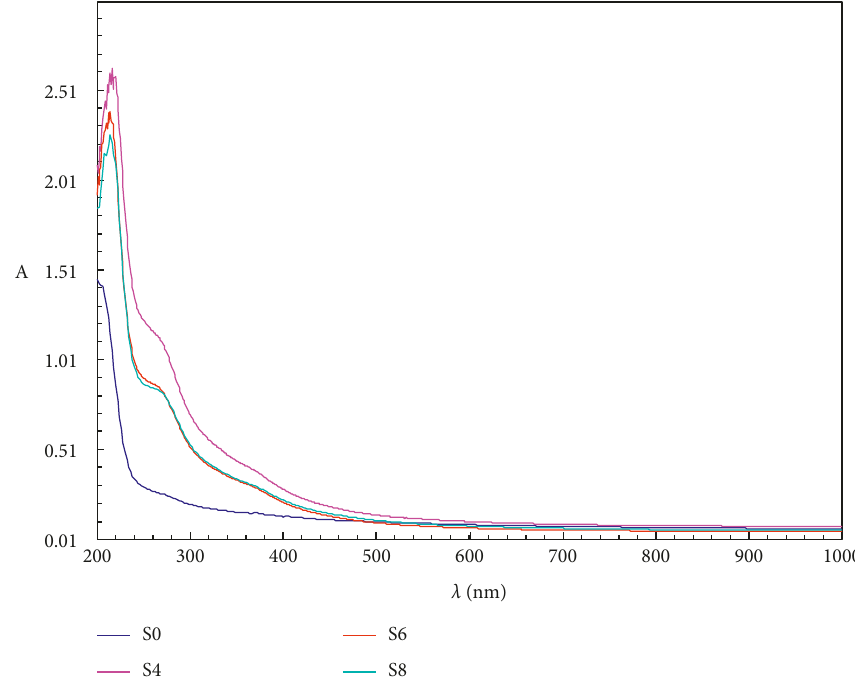
Figure 6: UV-visible spectra of CuONPs-doped HEC samples.